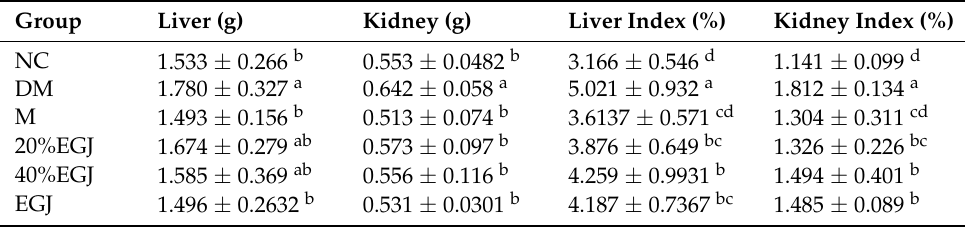
Table 2. Effect of the samples on the organ indexes in the diabetes mice.